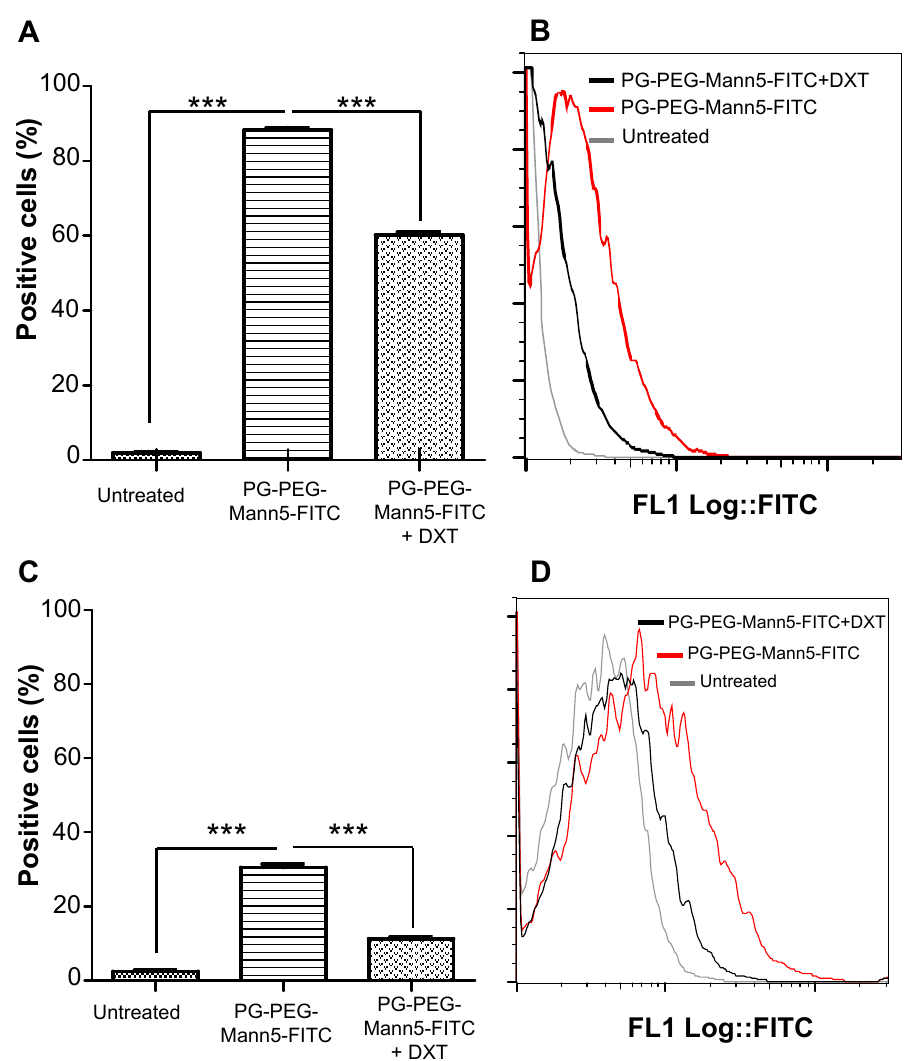
Figure 3. Dextran competition for CD206 receptor decreases the mannose decorated PG–PEG–Mann5–FITC nanoparticle uptake in murine macrophages RAW 264.7 and human THP-differentiated macrophages. ( A ) RAW 264.7 macrophages and ( C ) human THP-differentiated macrophages were preincubated for 30 min with or without 5 mg/mL of dextran before the addition of mannosylated nanocarriers. After 24 h incubation at 37 °C with nanoparticle, uptake was quantified by flow cytometry. Uptake is expressed as%. Values are means ±SD. Histograms show the Mean Fluorescent Intensity MFI that represents fluorescence inside the cells; ( B ) RAW 264.7 macrophages and ( D ) human THP-differentiated macrophages. Control untreated cells (gray), PG–PEG–Mann5–FITC without dextran (red), PG–PEG–Mann5–FITC with dextran (black). Black asterisks indicate P values for t- Student's test ( A , C ). Comparisons between PG–PEG–Mann5–FITC in dextran-free or dextran containing medium (*** p < 0.001).